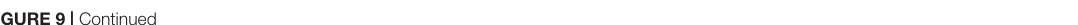
FIGURE 9 | Continued between Stroke-MET and OGD- Astro MET datasets. Red and blue pixels on the heatmap depict a high and low number of overlapping genes, respectively. Stroke-MET and OGD EC -MET display stronger hypergeometric overlap those with OGD Astro -MET transcriptome. (E,F) Overlapping up and downregulated genes between in vivo Stroke-MET and in vitro OGD- EC MET/OGD- Astro MET transcriptome are depicted in the Venn diagram. (G–J) Heatmap of log 2 FC of overlapping genes between Stroke-MET and OGD- EC MET/OGD- Astro MET transcriptome. The up and down regulated overlapping genes are shown in red and blue a change in gradients of these color correspond to the level of log 2 FC as shown on the scale bars. Genes classified based on the cellular location and the color coded as shown